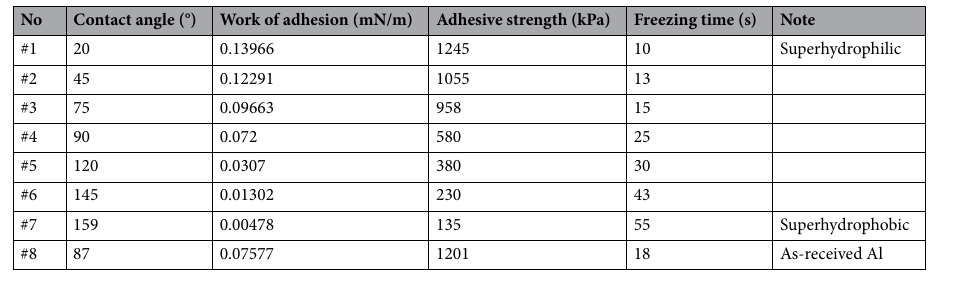
Table 1. Structural information of examined samples.